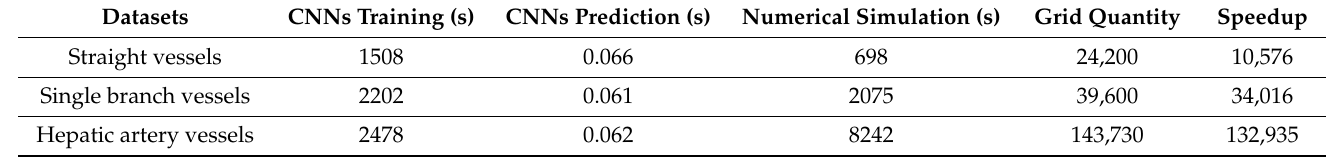
Table 2. Time consumption of the network model prediction and numerical